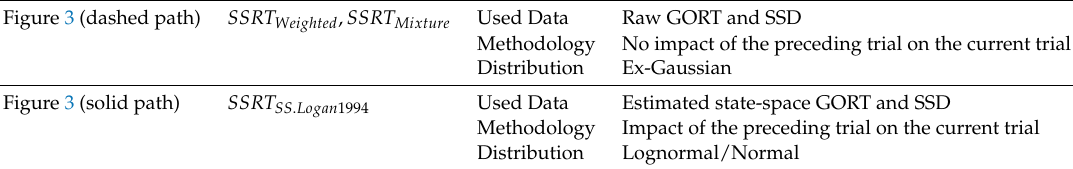
Table 2. Comparison of the time series-based and other methods of estimations of SSRT. Figure 3 (dashed path) SSRT Weighted , SSRT Mixture Used Data Raw GORT and SSD Methodology No impact of the preceding trial on the current trial Distribution Ex-Gaussian Figure 3 (solid path) SSRT SS . Logan 1994 Used Data Estimated state-space GORT and SSD Methodology Impact of the preceding trial on the current trial Distribution